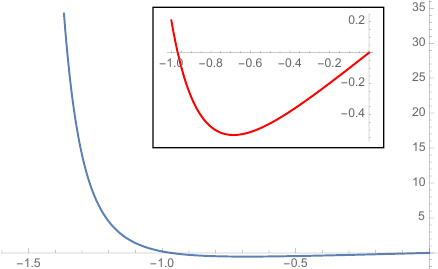
Figure 6. Plot of the coe(cid:14)cient of (cid:20) 2 in the numerator of eq. (3.6) (we have set m 0 = tan (cid:11) with (cid:11) 2 ( (cid:0) (cid:25)= 2 ; 0] ). It is negative between zero and and a critical value m s = tan (cid:11) s = (cid:0) 1 : 45221. For m < m s the coe(cid:14)cient is always